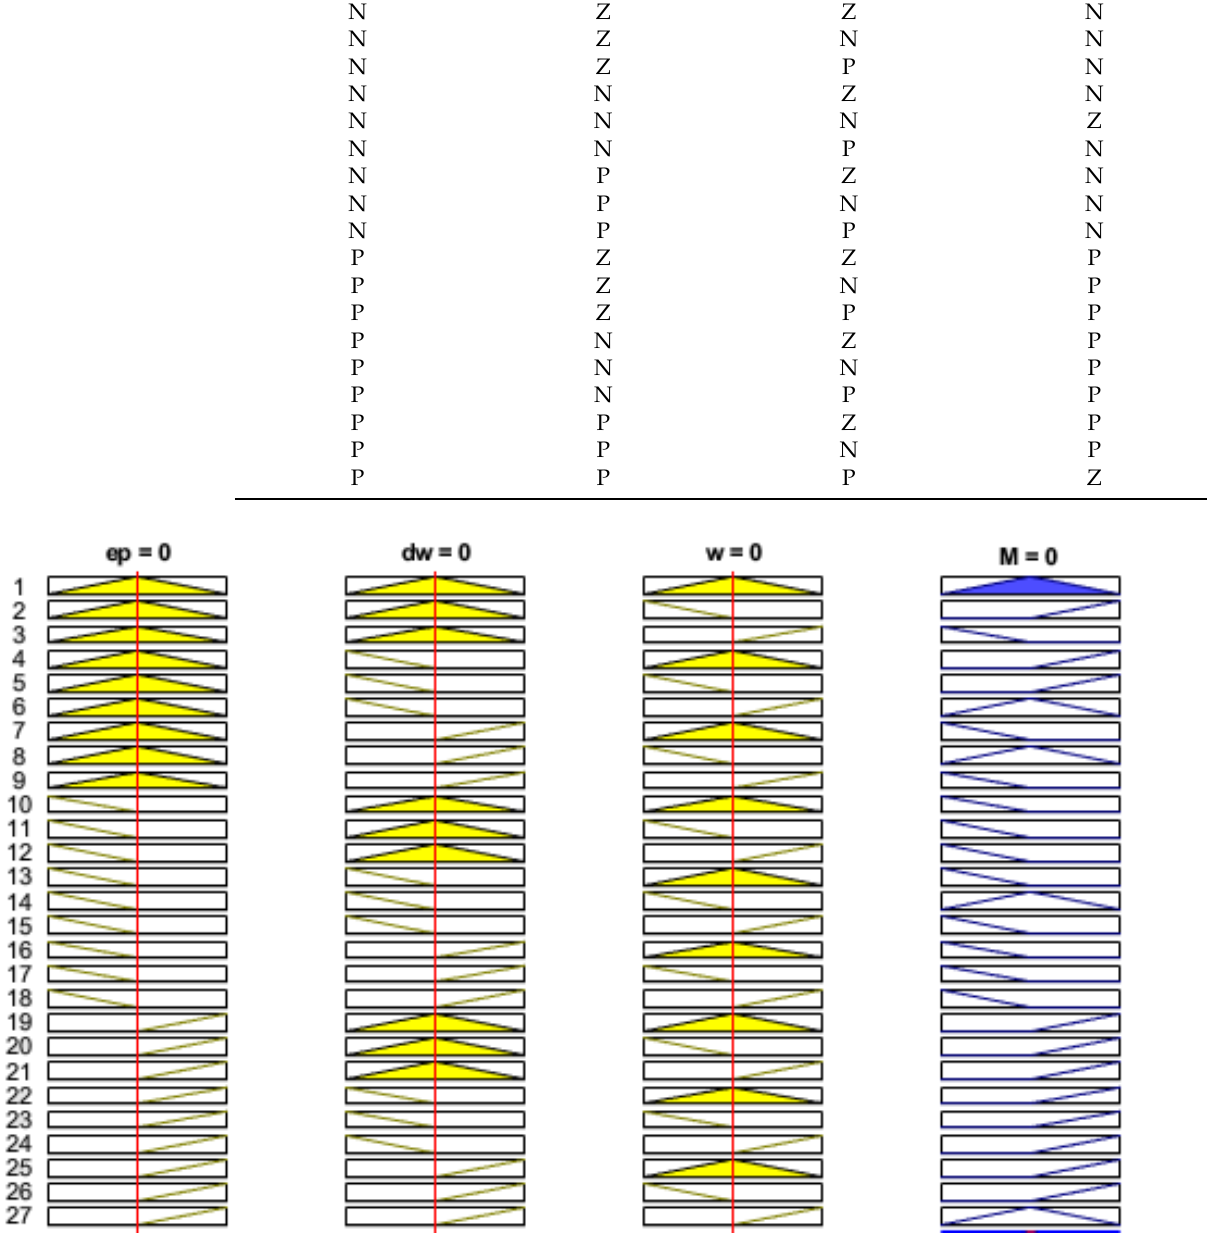
Figure 7. The membership functions and the variable values of 0 for rule ( Z, Z, Z, Z ).